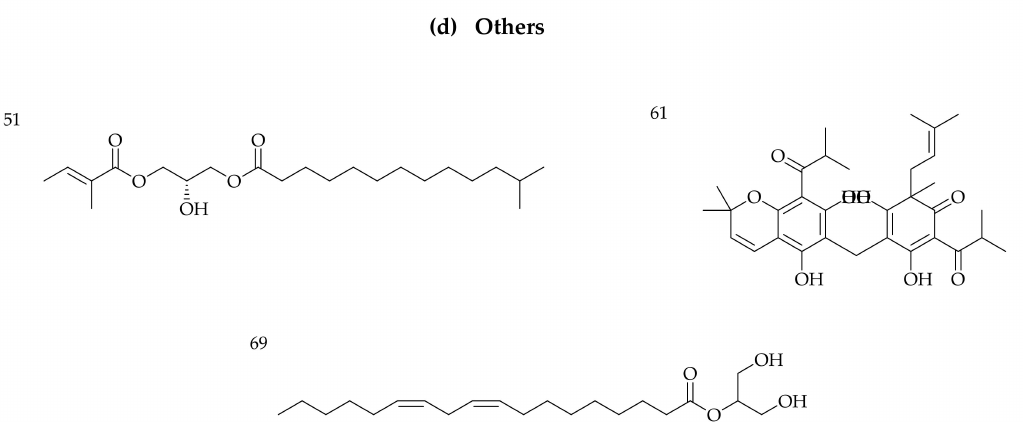
Figure 1. ( a – d ) Chemical structures of compounds identified in VAL and OGL from Kokori and Abraka. ( a ) organic acids and organic acid esters, ( b ) flavonoid, ( c ) terpenes ( d )